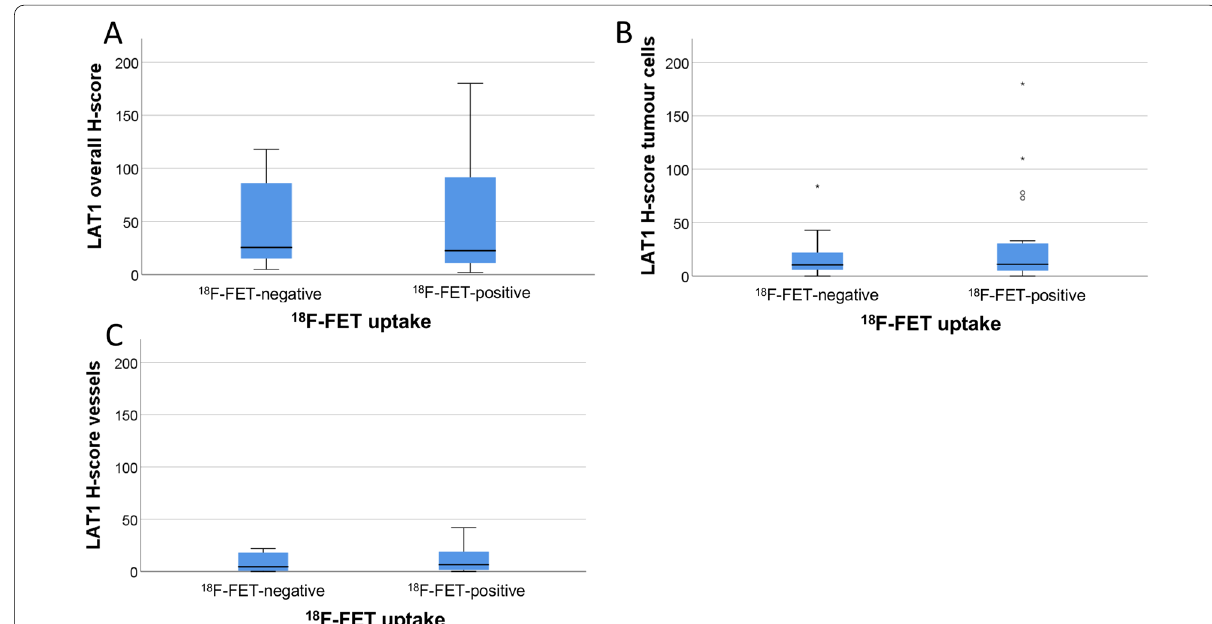
Fig. 2 LAT1 overall H‑score ( A ), the LAT1 H‑score tumour cells ( B ) and the LAT1 H‑score vessels ( C ) in the 18 F‑FET‑negative and 18 F‑FET‑positive gliomas